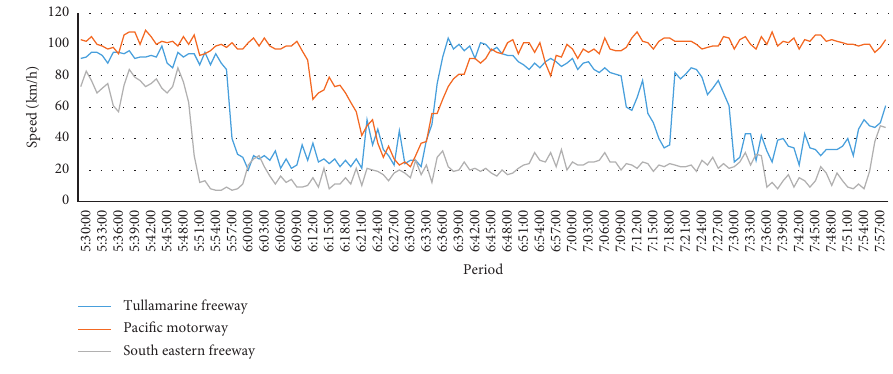
Figure 4: Samples of speed data for the three freeways.